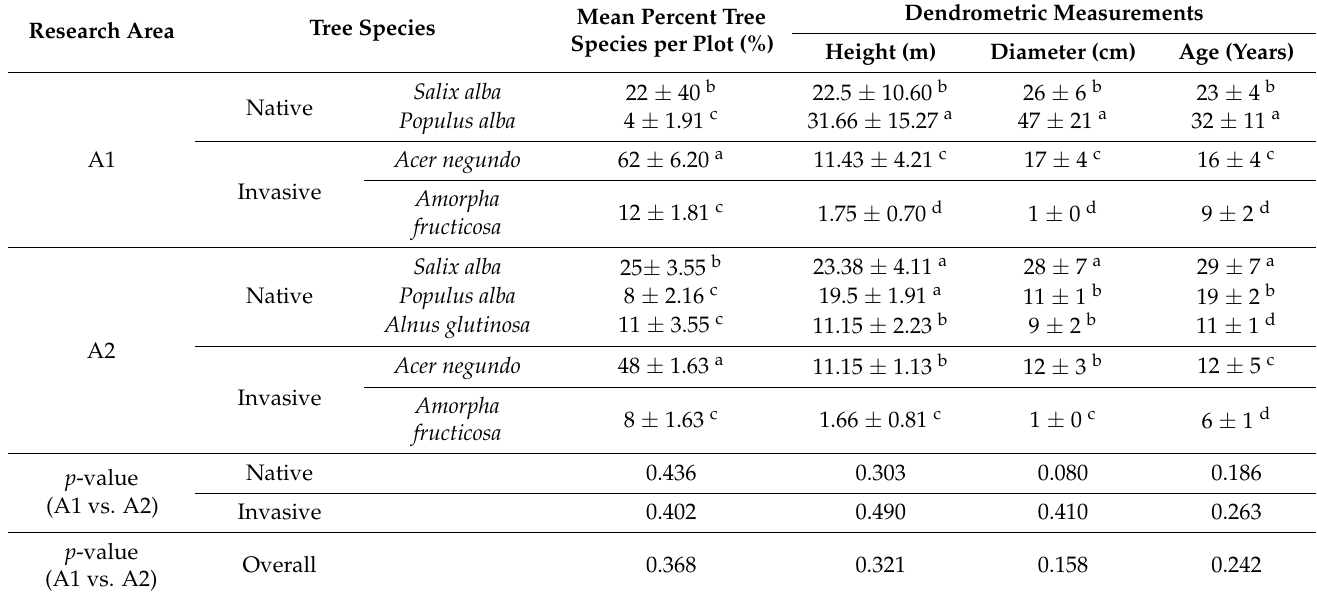
Table 3. Cover and allometric measurements of tree species in the two research areas. Values are given as average ± standard deviation. Effects were accepted as statistically significant if p ≤ 0.05. Values within the same column followed by a common letter are not significantly different according to t